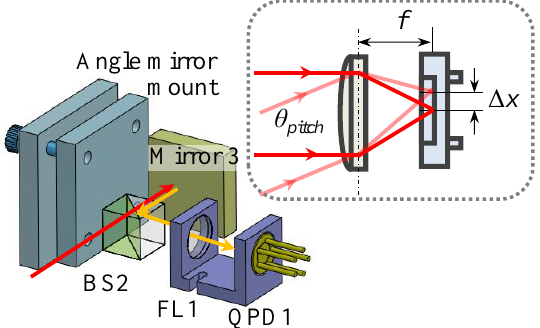
Figure 2. Optical layout of the miniature autocollimator kit.